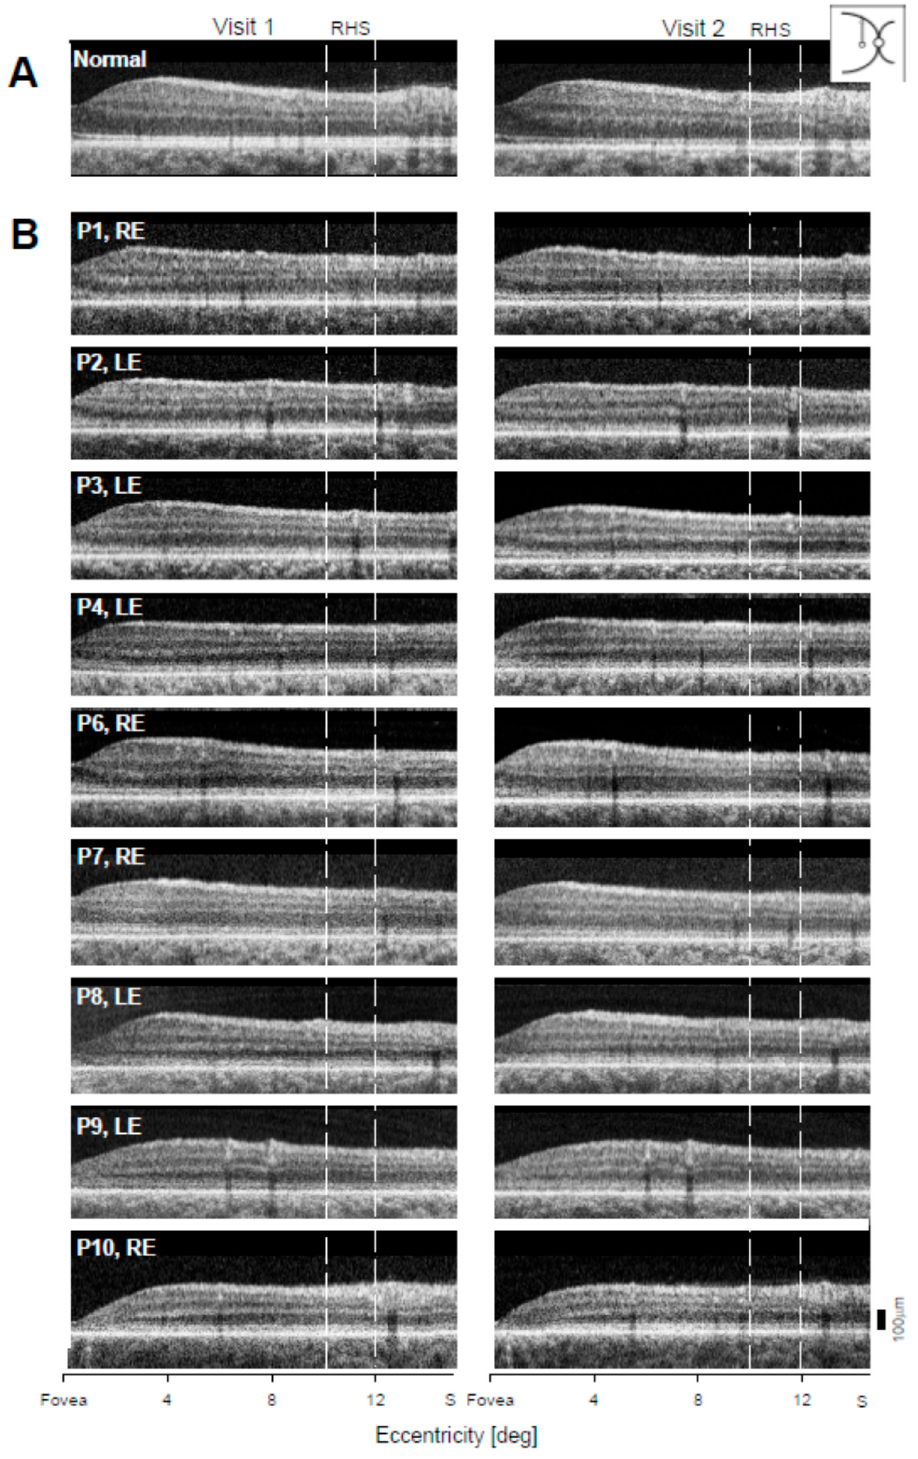
Figure 4. Superior retinal OCT scans in GUCY2D –LCA patients at two visits. ( A ) Normal vertical scans in superior direction starting at the fovea. ( B ) Scans of the nine LCA patients (P1–P4, P6–P10) on two visits separated by years, as specified in Supplementary Table S1. S, superior retina. White vertical dashed lines outline the range of eccentricities within the rod hotspot (RHS), where ONL measurements were made.